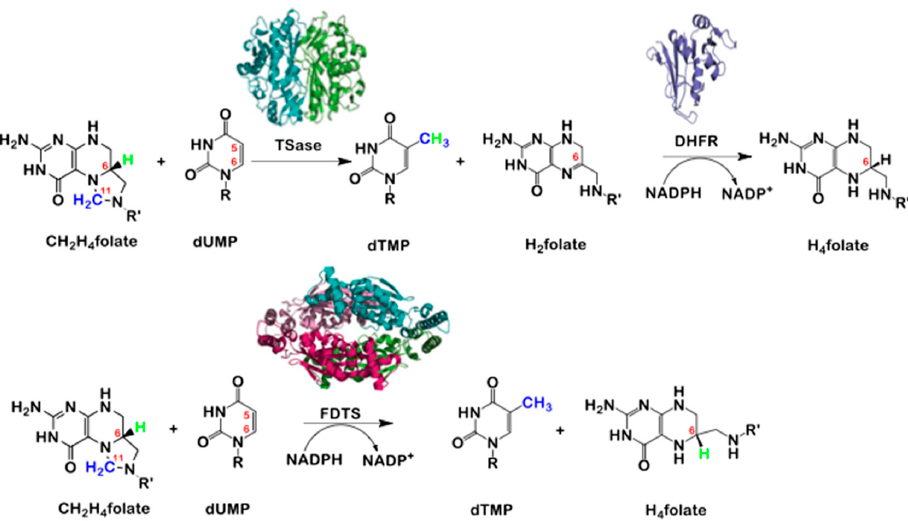
Scheme 1. Reactions catalyzed by TSase and DHFR ( top ), and FDTS ( bottom ). Highlighted are the